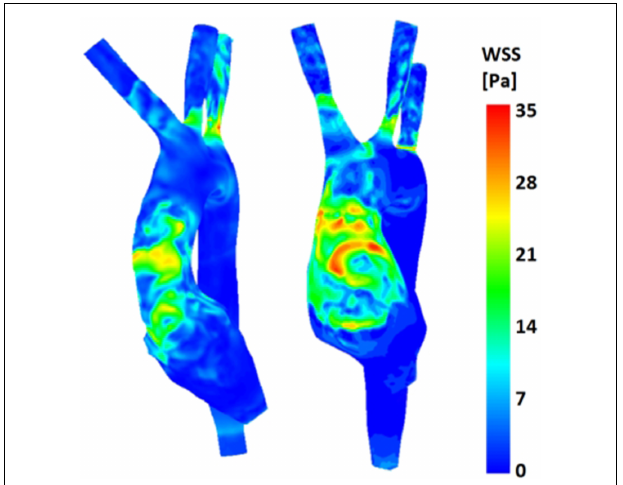
FIGURE 9 | Comparison of wall shear stress (WSS) distribution on the aortic wall for both control ( left ) and TGA ( right ) anatomies, highlighting higher WSS in anterior ascending aorta of the TGA model